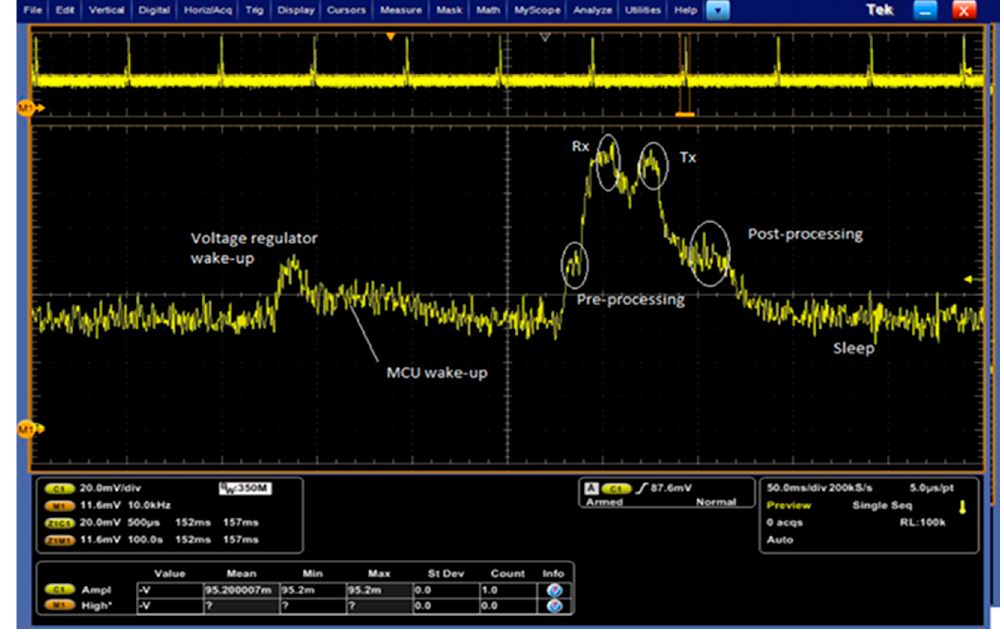
Figure 2. Connection event states for Intel A-101.